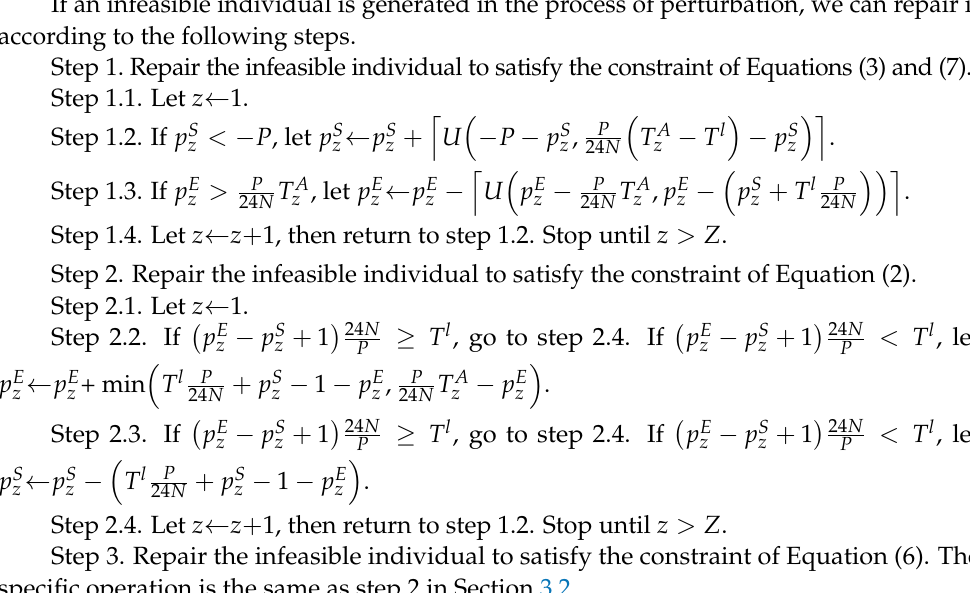
Figure 7. Greedy mutation example.